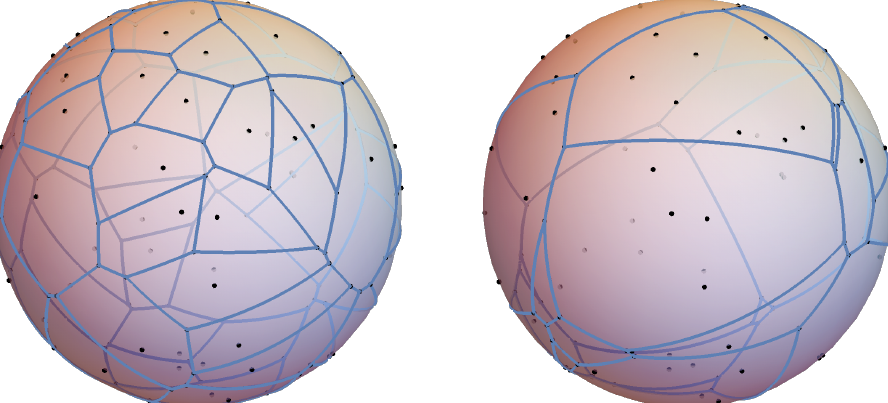
Figure 6. The Voronoi diagrams of 50 generators; ( left ) the ordinary spherical Voronoi diagram; ( right ) the spherical Laguerre Voronoi diagram with random weights. Certain cells lose in the case of the spherical Laguerre Voronoi